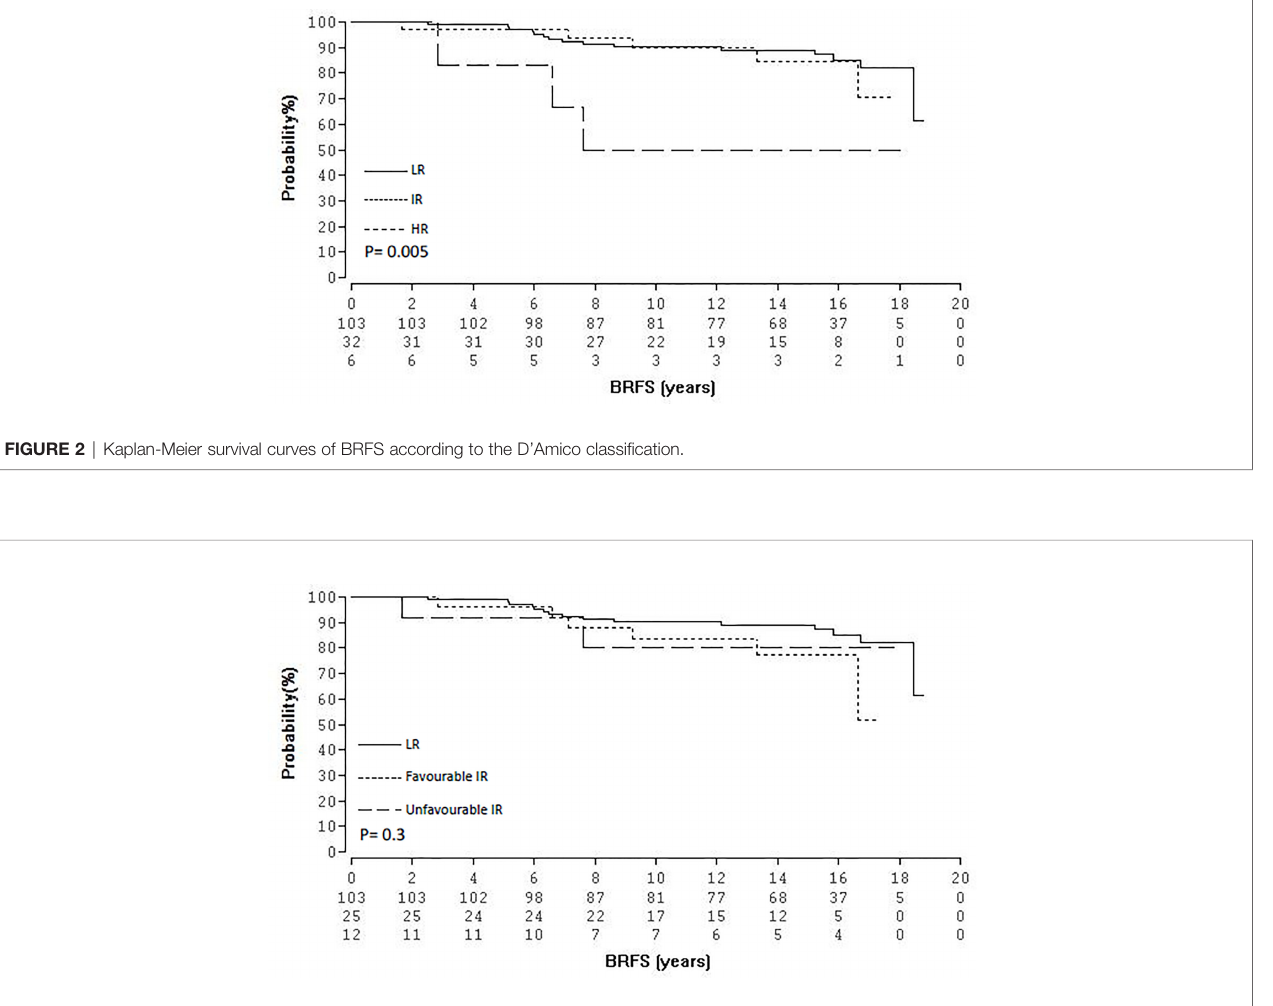
FIGURE 3 | Kaplan-Meier survival curves of BRFS according to the NCCN classi fi cation.